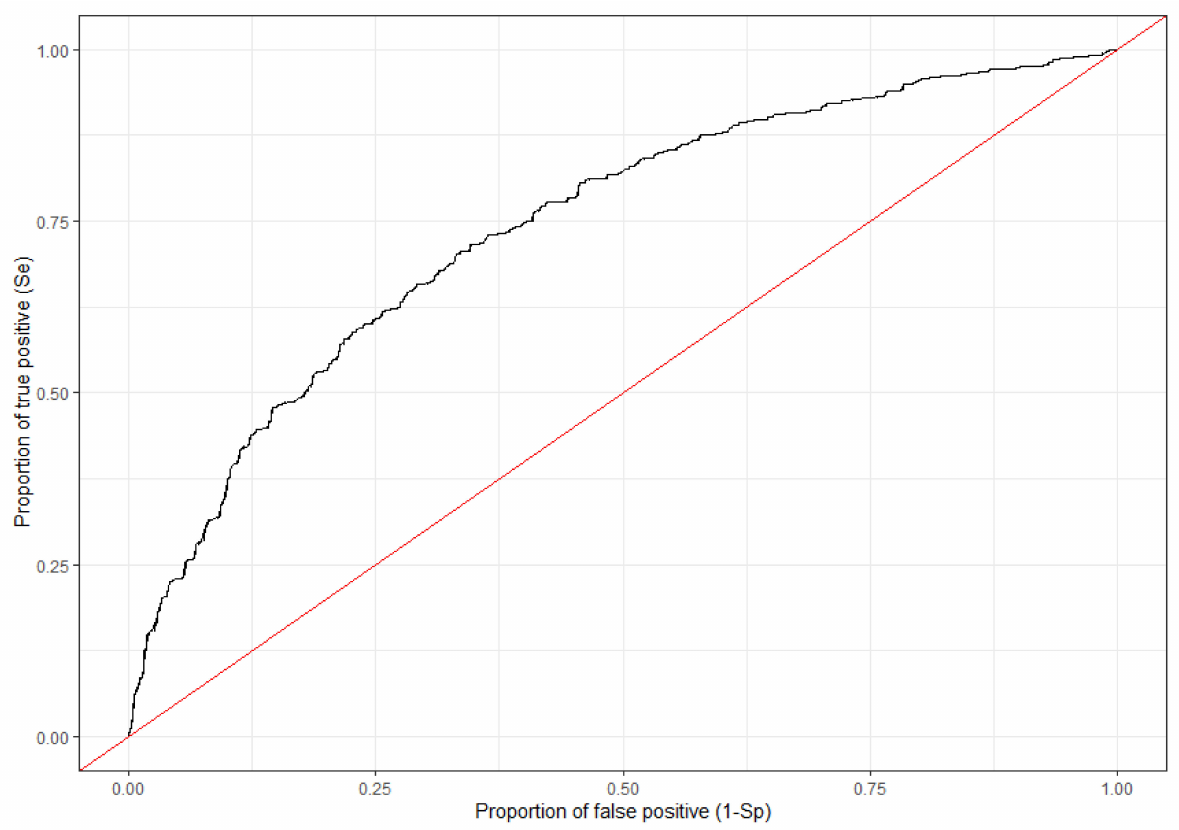
Figure 3. ROC curve (receiver operating characteristic curve) for the Generalized linear logistic regression model was plotted with the true positive ratio (Se) against the false positive ratio (1-Sp), where Se represented the y -axis and 1-Sp the x